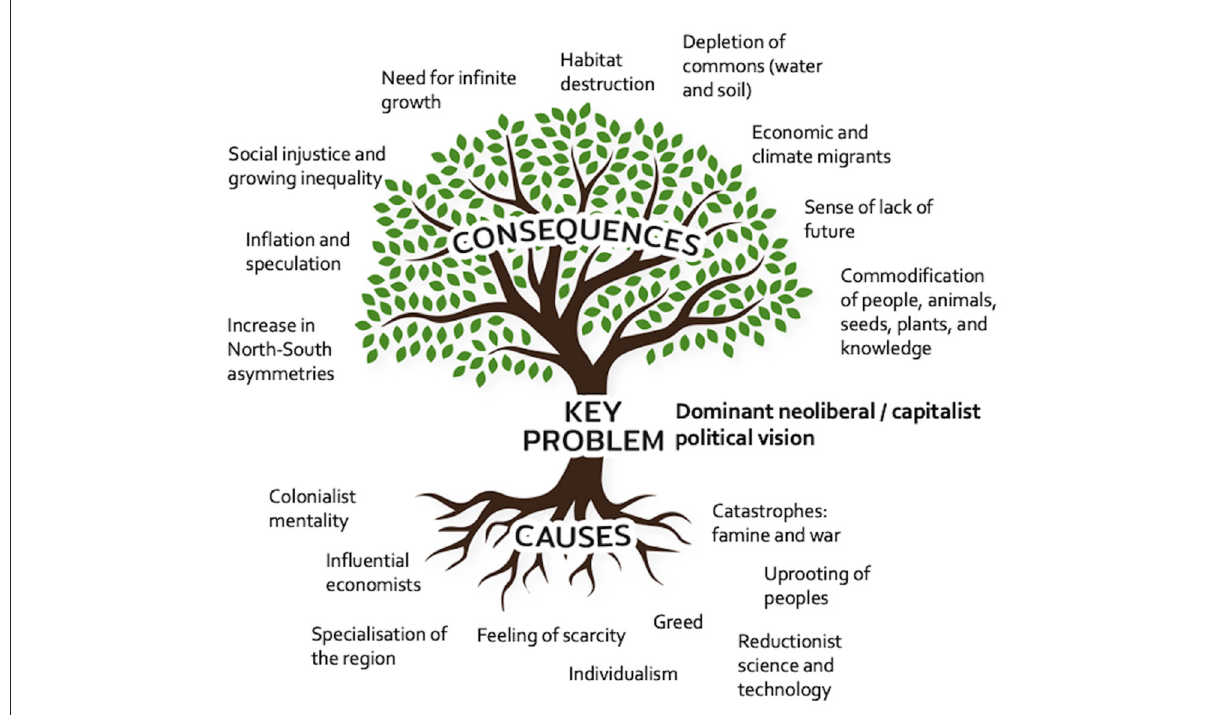
FIGURE4 Problem tree 1—Dominant neoliberal/capitalist political vision.